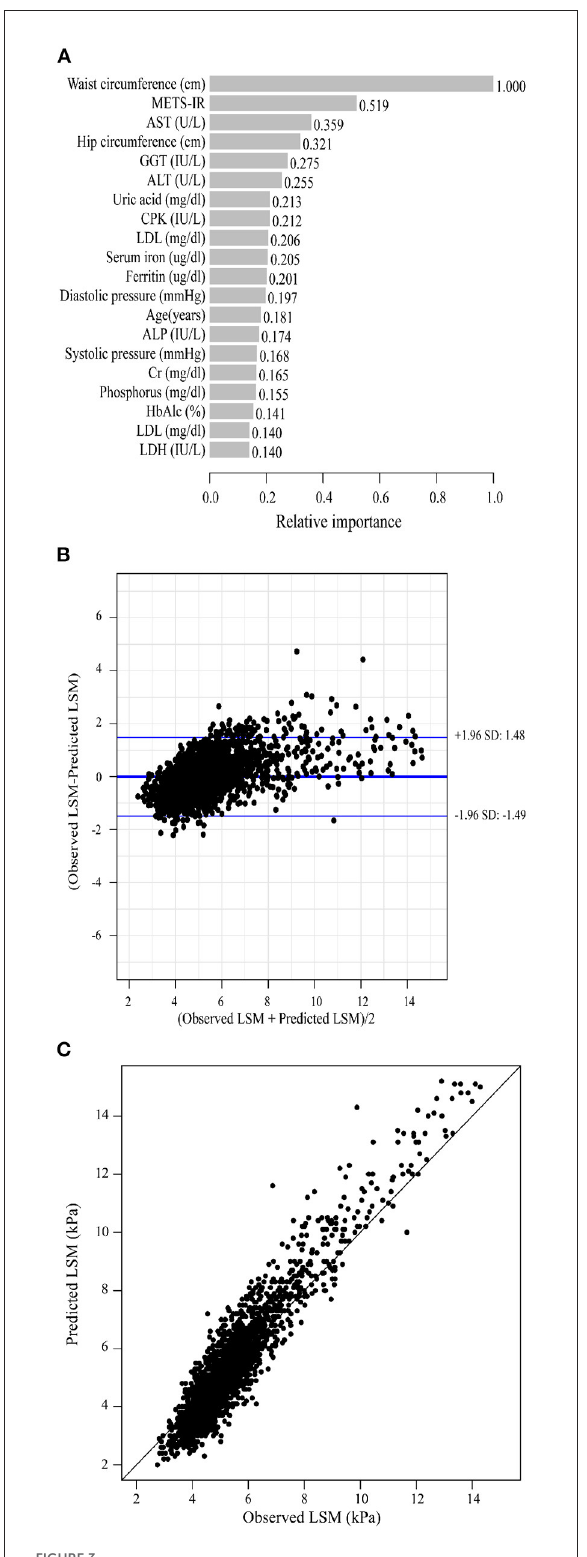
FIGURE3 XGBoost machine learning model developed with dataset B in the training cohort. (A) Relative importance of the top